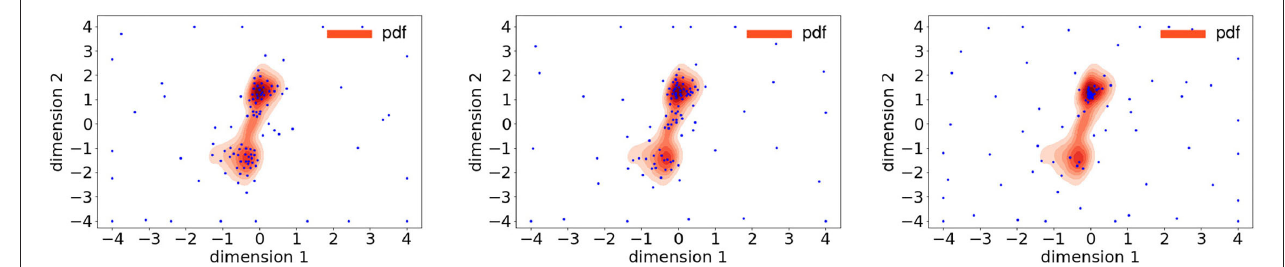
FIGURE 6 | Illustrations of training points (blue dots) selected using variance based on the log-normal process (left), entropy based on the log-normal process (middle), and upper confidence bound (UCB) based on the Gaussian process (right).